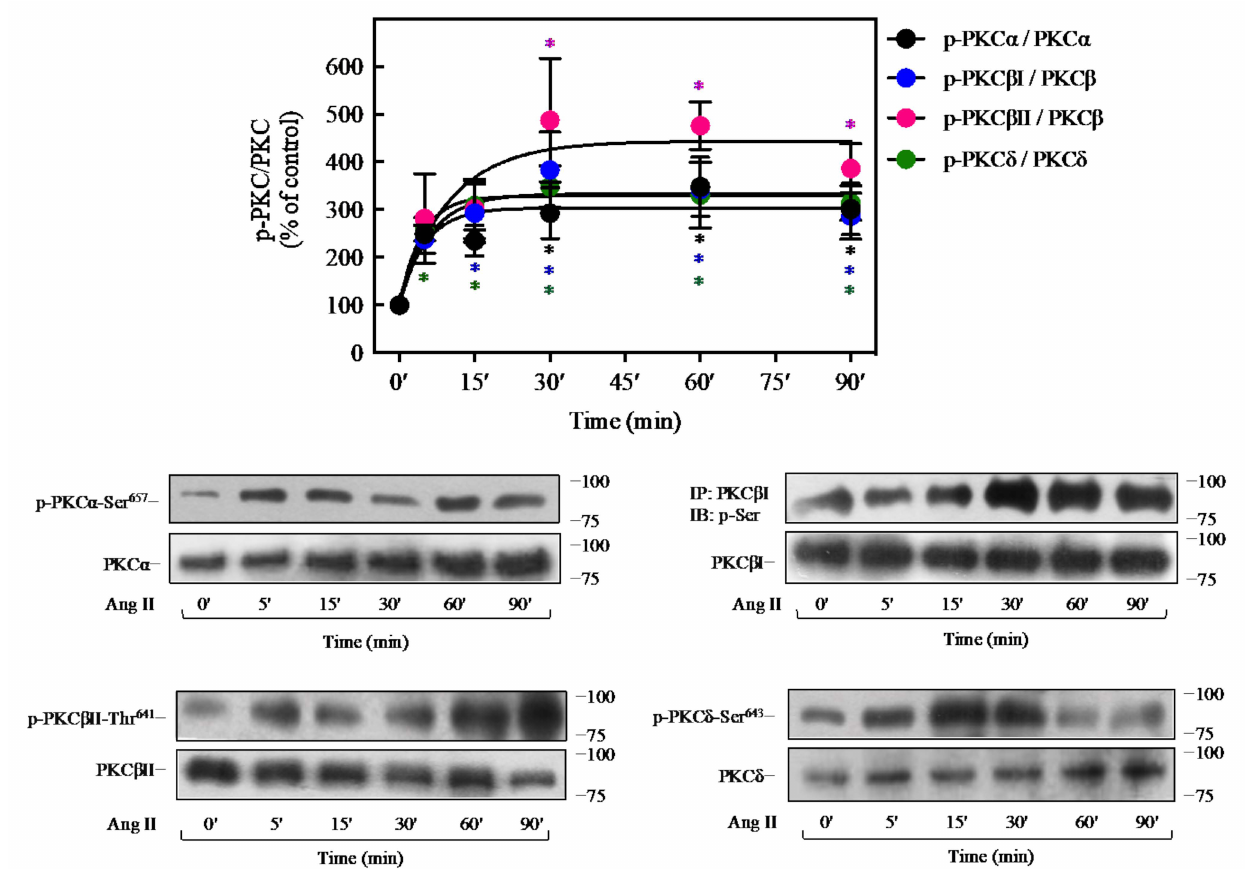
Figure 5. Ang II promotes the activation of PKC. 3T3-L1 adipocytes were treated with 100 nM Ang II for the indicated times. Under all experimental conditions, cells without treatment were considered as controls. Total cell lysates were separated by SD-PAGE and analyzed by immunoblotting with anti- p-PKC α Ser 657 , anti-p-PKC β II Thr 641 , or anti-p-PKC δ Ser 643 antibodies. For PKC β I, total cell lysates were immunoprecipitated with anti-PKC β I before SDS-PAGE analysis and immunoblotted with an anti-phospho-Ser antibody. Blots were quantitated by densitometry, and the mean values were plotted from three-five independent experiments. Vertical lines represent the S.E.M. Representative immunoblots are presented. Western blots were also probed for total PKC α , PKC β I, PKC β II, or PKC δ as a loading control. * p < 0.05 vs. time 0 (cid:48) . The different asterisk colors indicate the corresponding group and represent the significance with respect to control within the same